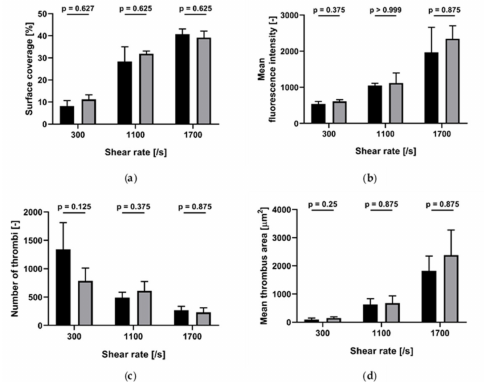
Figure 1. E ff ect of storage temperature (room temperature (RT) and 37 ◦ C) on platelet accumulation on collagen (200 µ g / mL)-coated channels at di ff erent wall shear rates ( n = 4). Black: RT; grey: 37 ◦ C. ( a ) Surface coverage; ( b ) mean fluorescence intensity; ( c ) number of thrombi; ( d ) mean thrombus area. Data are represented as column bar graphs, with means ± standard errors of the mean and analyzed by Wilcoxon matched